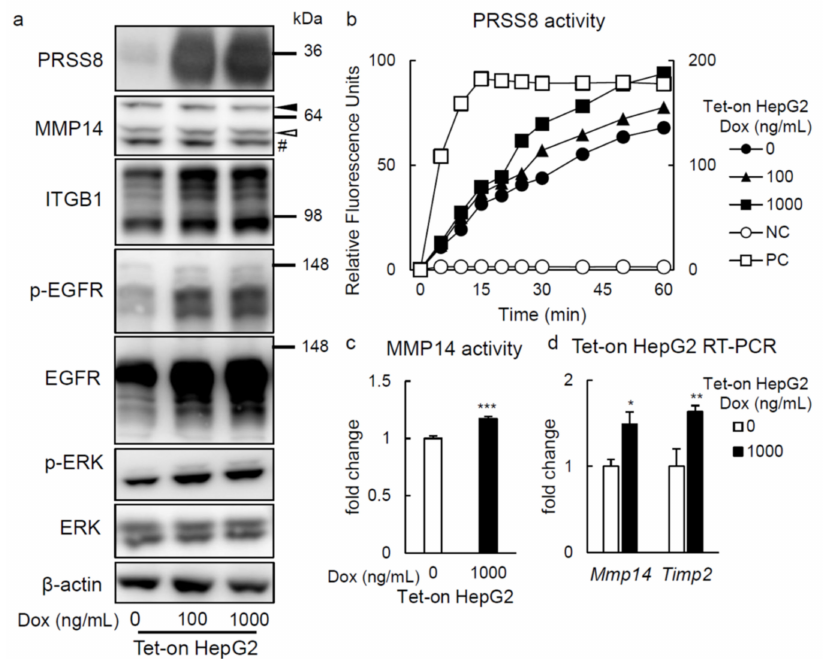
Figure 4. Tet-on HepG2 cells were generated and over expression of PRSS8 activated MMP14 cas- cades. ( a ) Representative Western blot of three independent experiments for PRSS8 and matrix metalloproteinase (MMP) 14 cascade in the Tet-on HepG2 cells under 72 h exposure to each con- centration of doxycycline (Dox) conditions. A solid arrow head; pro-MMP14, an open arrow head; activated MMP14, #; nonspecific bands. ( b ) Representative PRSS8 activity measured by fluorogenic substrate (Acetyl-Lys-His-Tyr-Arg- α -[4-methylcoumaryl-7-amide]) of four independent experiments in the Tet-on HepG2 cells. The negative control (NC; T-PER Tissue Protein Extraction Reagent) and positive control (PC; trypsin 1 µ g) were located. The right vertical axis is for PC and the left vertical axis for all others. ( c ) The MMP14 activity of the Tet-on HepG2 cells was measured (n = 4 per group). Values are shown as the mean ± SEM; *** p -value < 0.001 ( t test). ( d ) RT-PCR of MMP14 and tissue inhibitor of metalloprotease (TIMP) 2 genes in the liver of the Tet-on HepG2 cells under 72 h exposure to each concentration of Dox conditions (n = 4–6 per group). Values are shown as the mean ± SEM; * p -value < 0.05 and ** p -value < 0.01 ( t